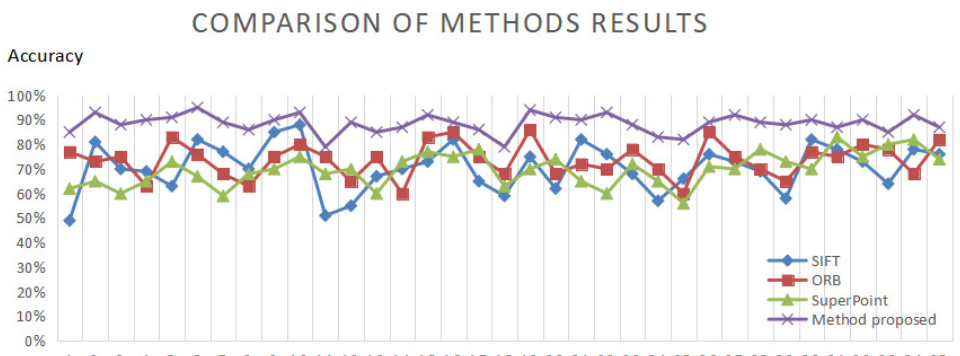
Figure 5. Accuracy of feature points detection and matching results.